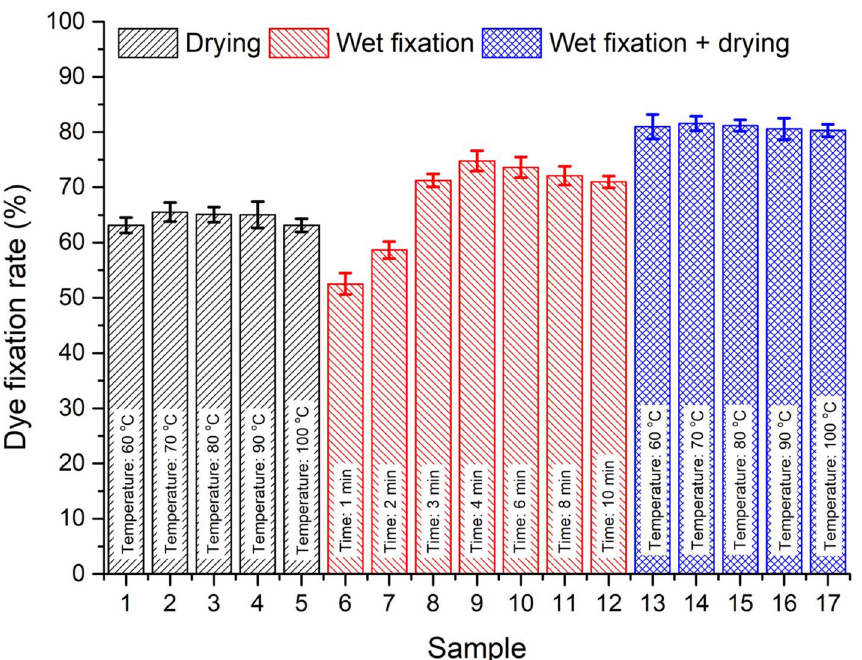
Figure 4. Dye fixation rate of direct drying (sample 1–5), wet fixation treatment for varied times (samples 6–12), and a combination of wet fixation and drying at varied temperatures (samples